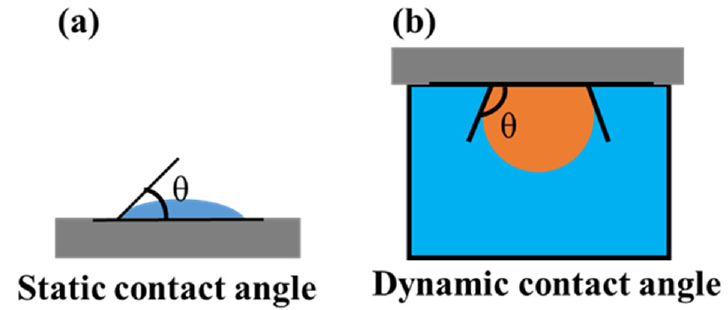
Figure 1. The ( a ) static, and ( b ) dynamic contact angles’ measurements. The surface wettability influenced the fluid flow, which has been widely studied in previous studies [31–34]. The results indicated that as the surface became more hydrophilic, the fluid flow became faster [35,36]. Rumbidzai A. E. Nhunduru [23] et al. studied the impact of wettability on pore-scale flow regimes. The result showed that the pore scale wettability influenced the fluid flow property. The wettability had an impact on the fluid phase connectivity, and the fluid flow property was influenced. Pengyu Wang et. al. [37] explored the surface wettability by molecular dynamics, and the results indicated that there are three contact states on the surface under the vibration field: wetting, wetting/dewetting, and dewetting. In addition, the results also indicated that the surface wettability influenced the fluid flow